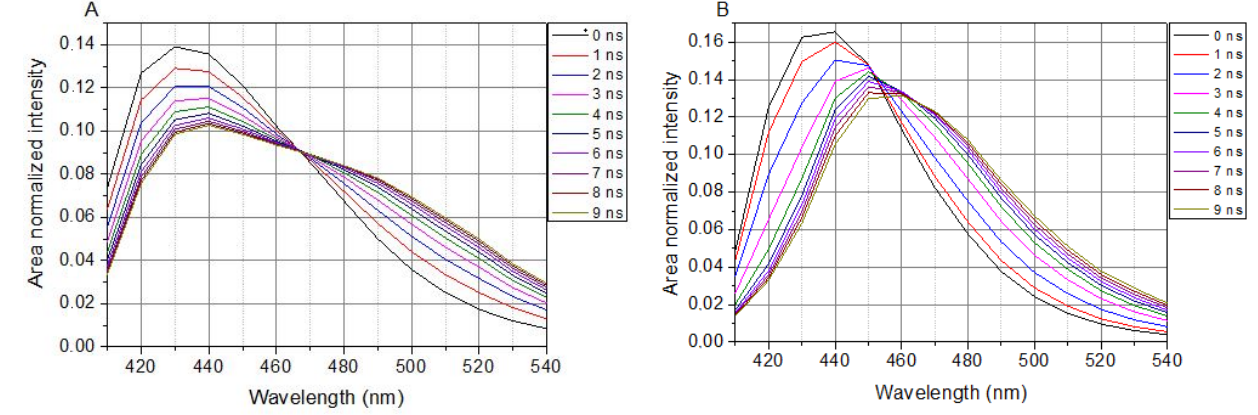
Figure 3. TRANES of LAURDAN. ( A ), Laurdan in cell suspension; ( B ), Laurdan in non-cell solution. λ ex = 369 nm.